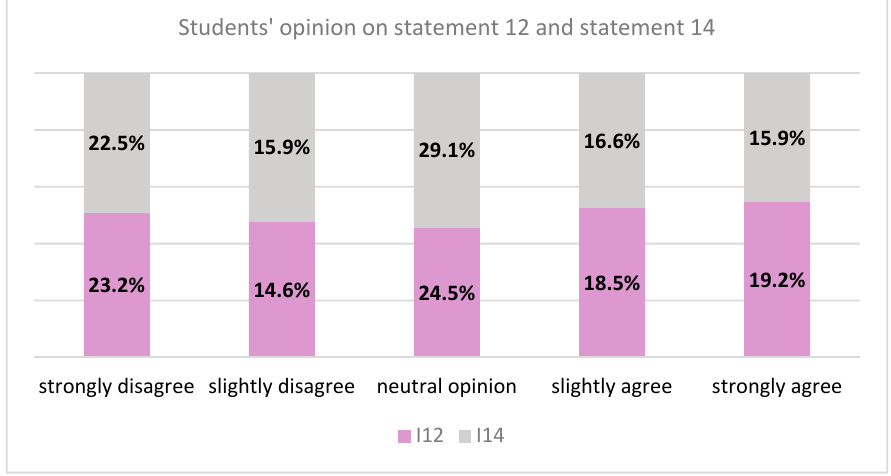
Figure 2. Opinion on statement 12 and statement 14.